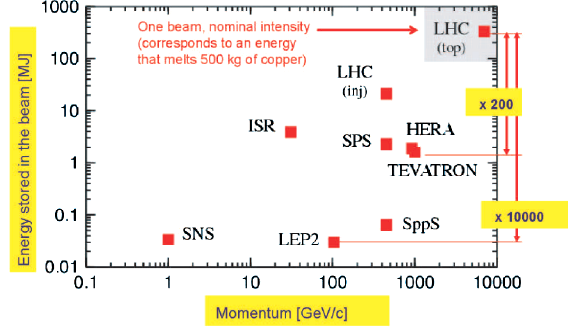
FIG. 1. Energy stored in the beams as a function of the particle momentum for different accelerators: CERN-ISR [36], CERN- LEP2 [36], DESY-HERA [37], FERMILAB-TEVATRON [38], ORNL-SNS [39], and